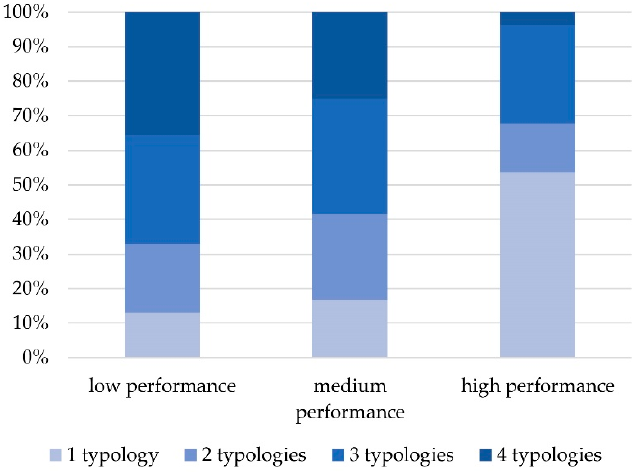
Figure 5. Number of contracts offered by performance category.